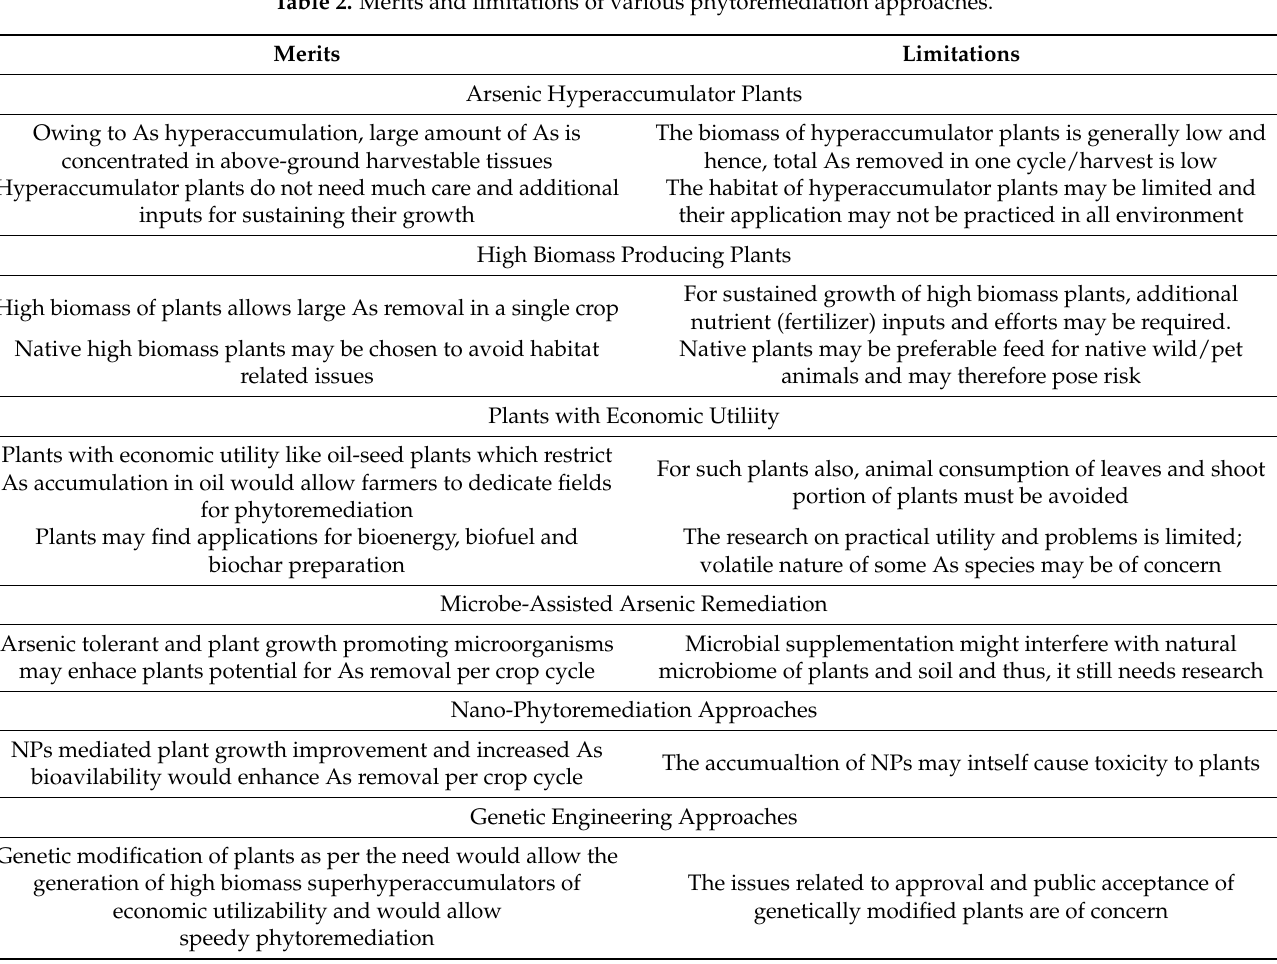
Table 2. Merits and limitations of various phytoremediation